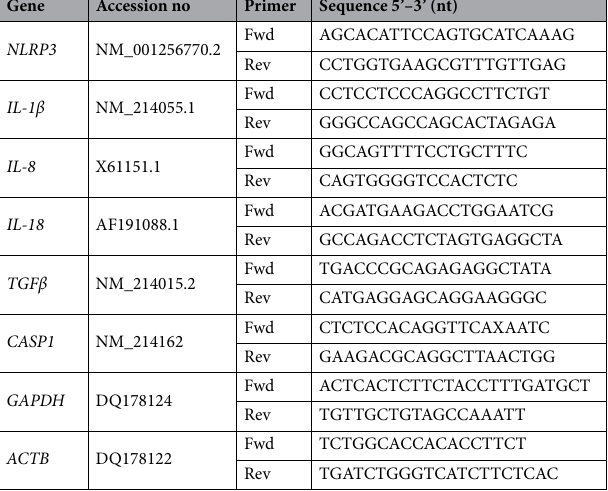
Table 2. Accession numbers and primer sequences of genes amplified by qRT-PCR. Primer sequences are taken from Loss et al. 87